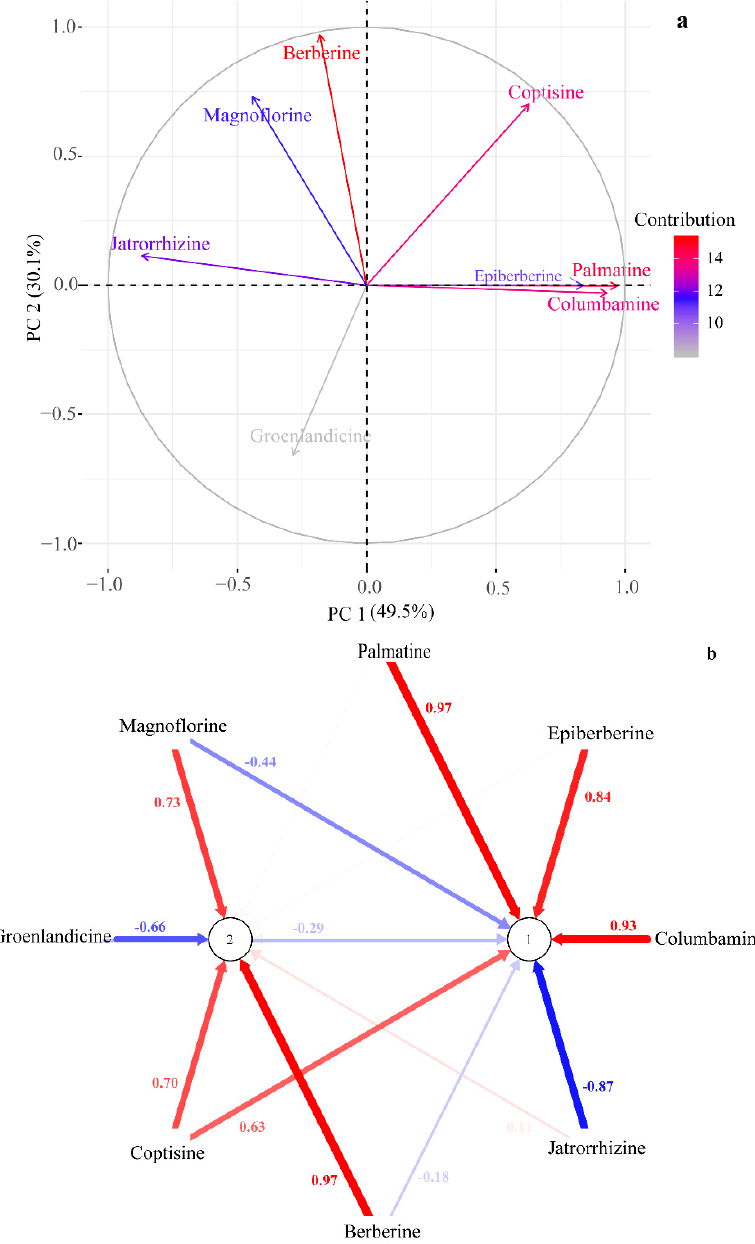
Figure 3. ( a ) Loading plot of PCA; ( b ) Score of each variable on PC 1 and PC 2.